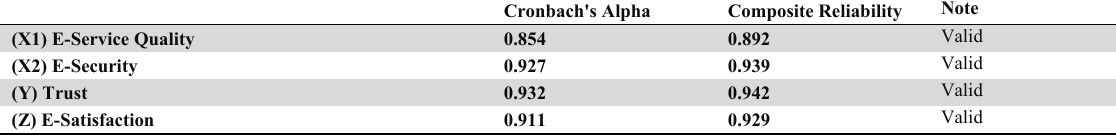
PLS Algorithm - Composite Reliability Test Results